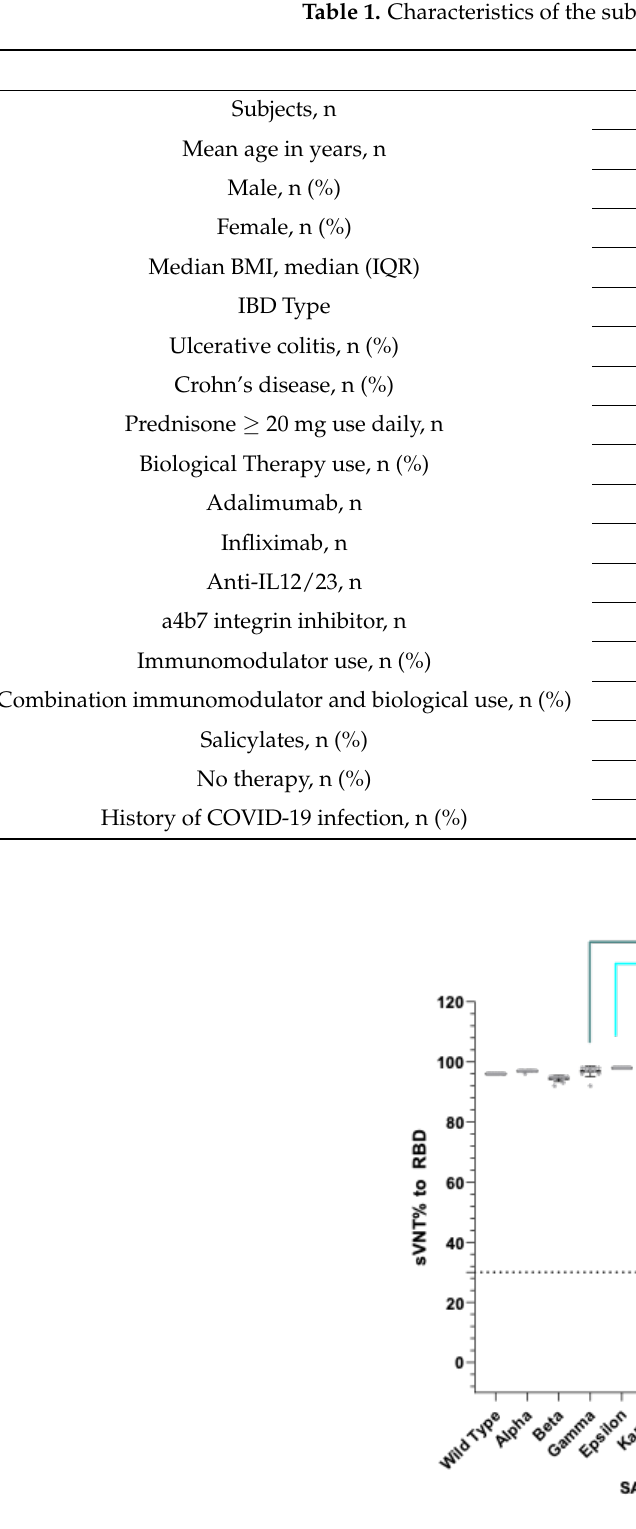
Table 1. Characteristics of the subjects in the study.